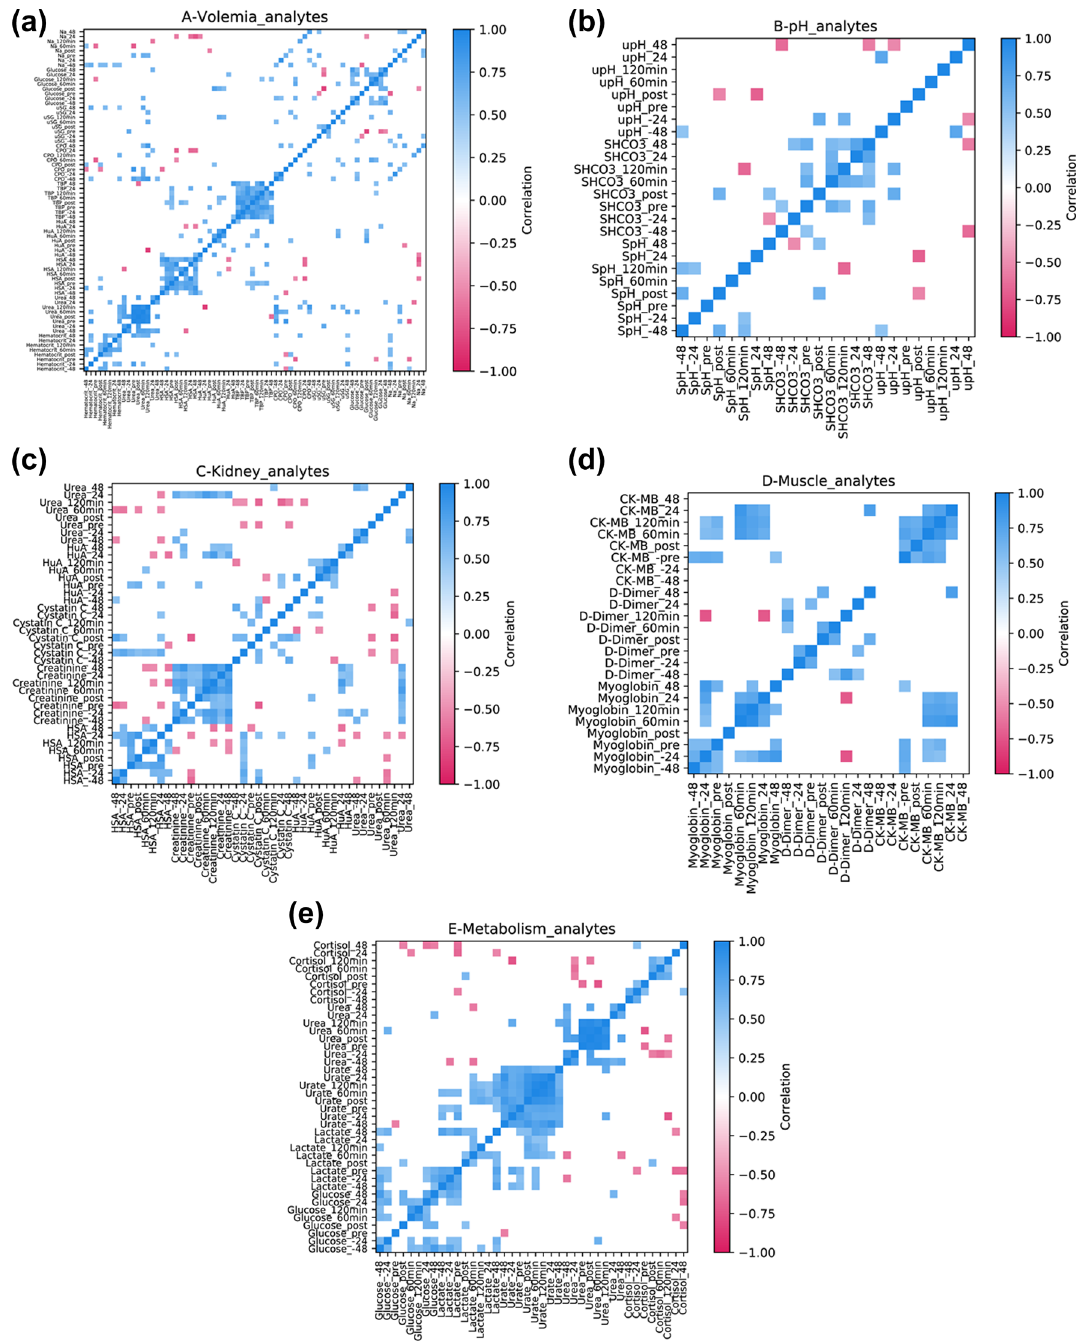
Figure 8. Analyte correlations with the CCombat protocol. Correlation matrices related to ( a ) volemia (hematocrit; urea; serum albumin concentration (HSA); total blood proteins (TBP); sodium; glucose; calculated plasma osmolality (CPO); urine specific gravity (uSG) and urinary albumin (HuA)); ( b ) pH (blood pH (SpH); serum bicarbonate (SHCO3); urine pH (upH)); ( c ) kidney (serum albumin concentration (HSA); serum creatinine; cystatin C; urinary albumin (HuA); urea); ( d ) muscle (myoglobin; d-dimer and CK-MB); ( e ) metabolism (glucose; lactate; urate; urea and cortisol). The discussion focuses only on pairs with rs > 0.5 and a significance of p <